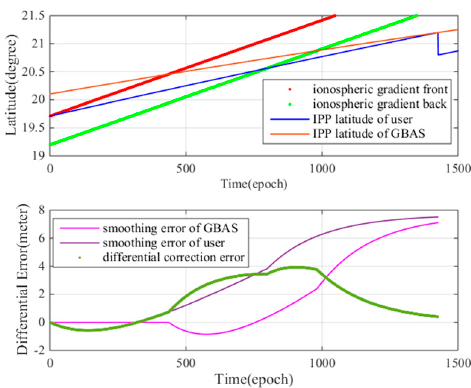
Figure 18. ( a ) relative position between the abnormal ionospheric gradient and the GBAS IPP; ( b ) ionosphere gradient impact on GBAS. ( b ) ionosphere gradient impact on